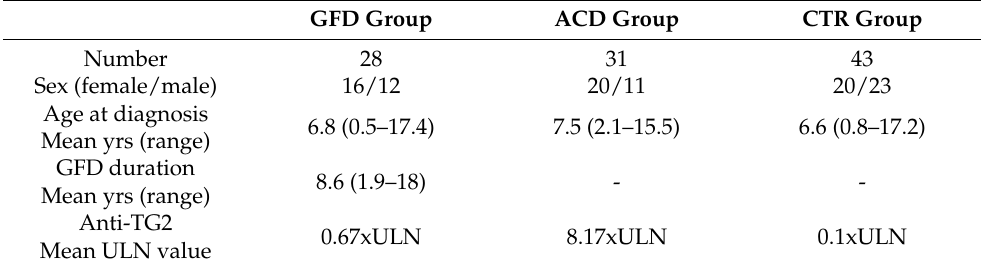
Table 1. Clinical features of enrolled